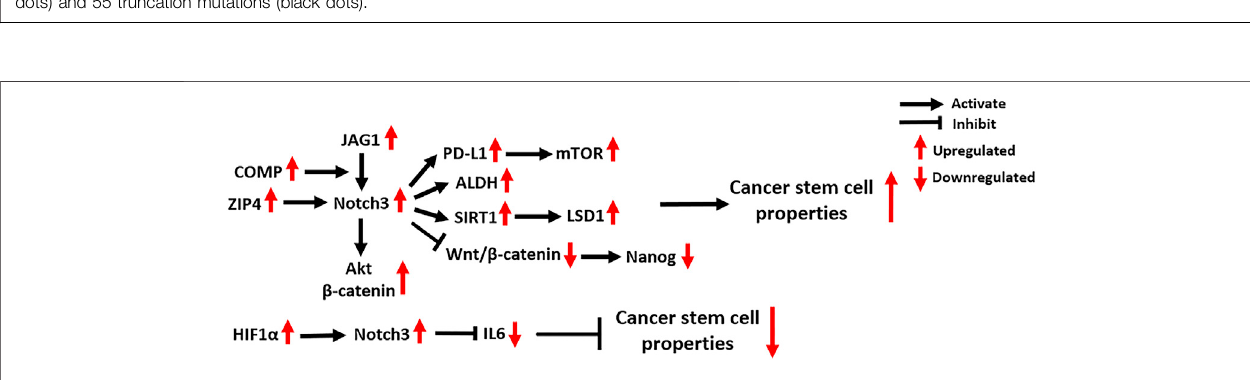
FIGURE 4 | Notch3-related molecular mechanisms in cancer stem cells. COMP: Cartilage Oligomeric Matrix Protein; Akt: AKT Serine/Threonine Kinase; PD-L1: Programmed Death Ligand 1; ALDH: Aldehyde dehydrogenase; SIRT1: Sirtuin 1; LSD1: Lysine-speci fi c demethylase 1; HIF1 α ： Hypoxia Inducible Factor 1 Subunit Alpha; IL6: Interleukin